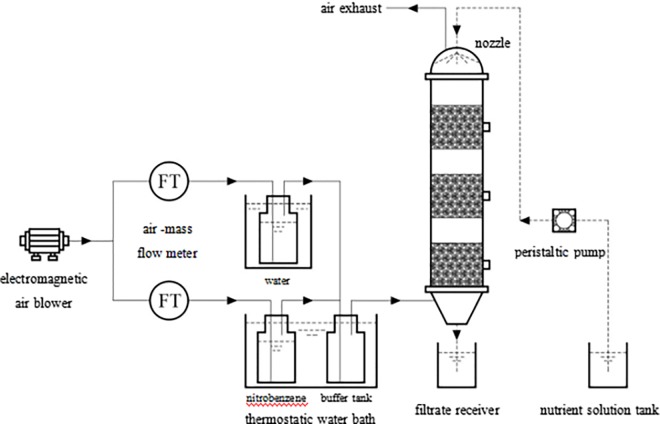
Schematic representation of the experimental setup.